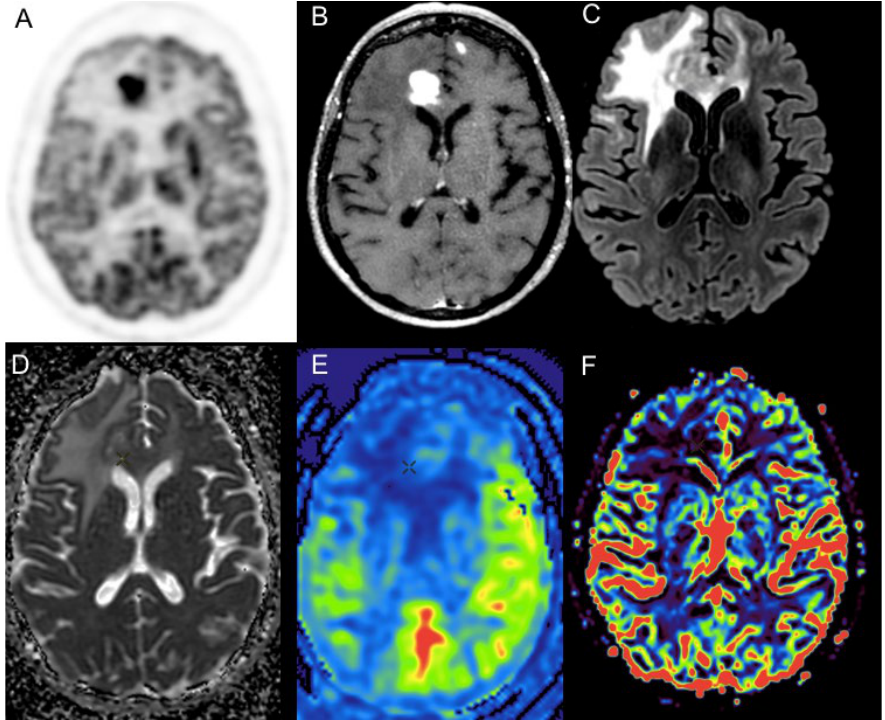
Figure 2. Primary central nervous system lymphoma in a 72-year-old female patient with typical PET and MRI features: high and homogeneous 18 F-FDG PET uptake (SUVmax = 27, T/N = 2.1) ( A ); “snowball” pattern with intense and homogeneous enhancement after gadolinium enhancement ( B ); extensive hypersignal on T2-FLAIR weighted images, respecting perilesional edema and respecting the cortical ribbon ( C ). Parametric ADC map show only moderate diffusion restriction ( D ), and no hyperperfusion is detectable either on arterial spin labelling ( E ), or dynamic susceptibility contrast ( F , rCBV parametric map) perfusion sequences.